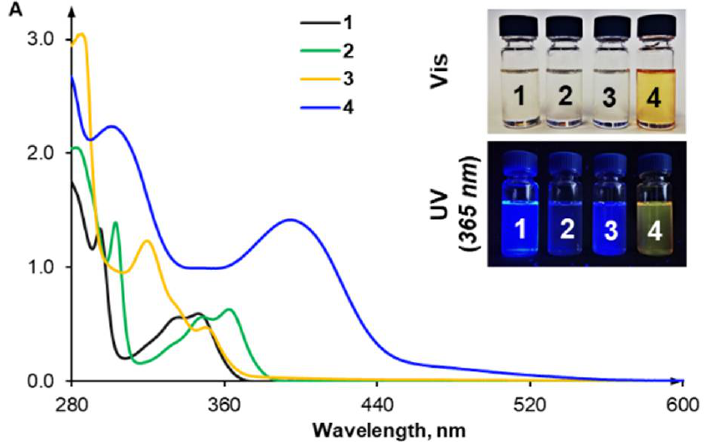
Figure 7. UV-vis spectra of receptors 1 – 4 ( 10 −4 M) in the presence of 2 equiv. of TfOH in DMSO + 0.5% H 2 O at 298 K. Inset: the same solutions under visible light and under UV irradiation (365 nm).